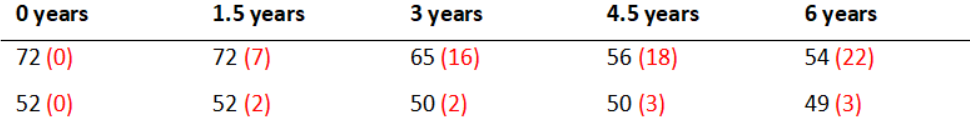
Figure 2. Kaplan – Meier curves illustrating risk of dementia onset (onset of questionable or very mild dementia; conversion to CDR ≥ 0.5) among cognitively healthy participants as a function of CSF NfL over 6 years. Cognitively healthy (CH) participants ( n =